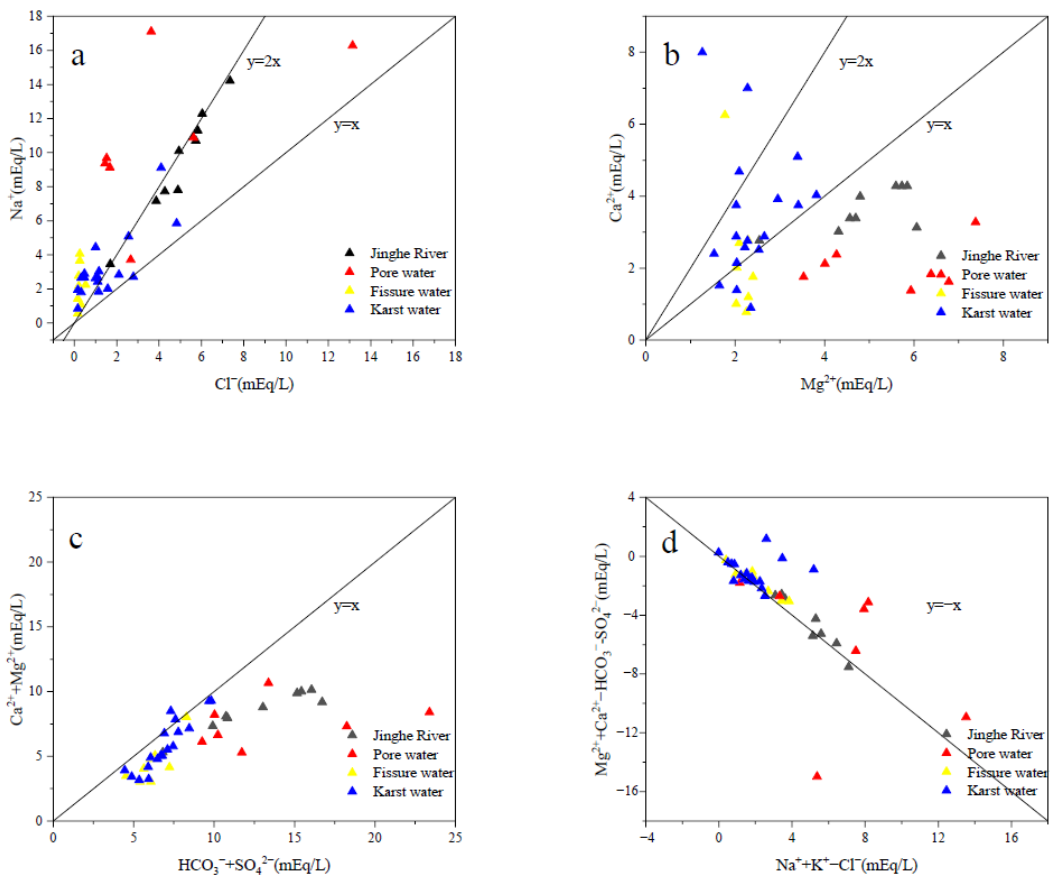
Figure 4. Ion proportion relationship of different water bodies.